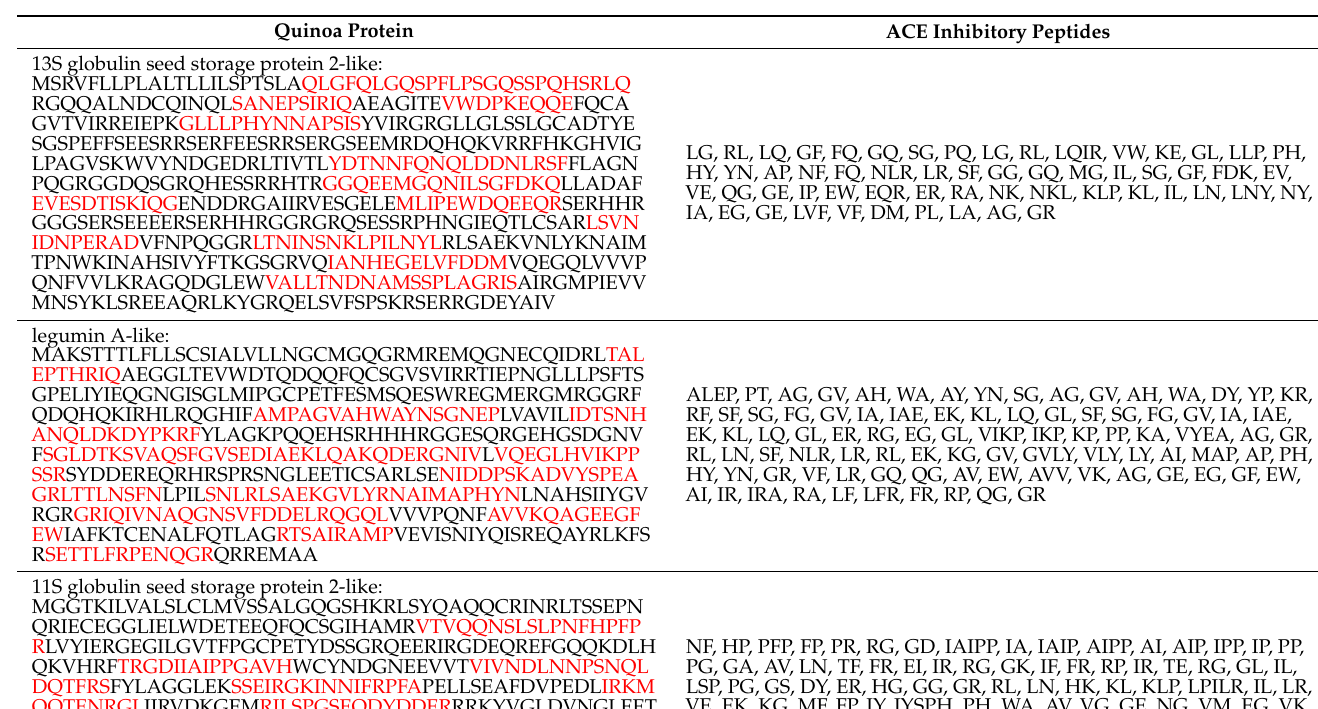
Table 1. Main protein precursors of identified peptides, and potential ACE inhibitors in matched sequences using BIOPEP